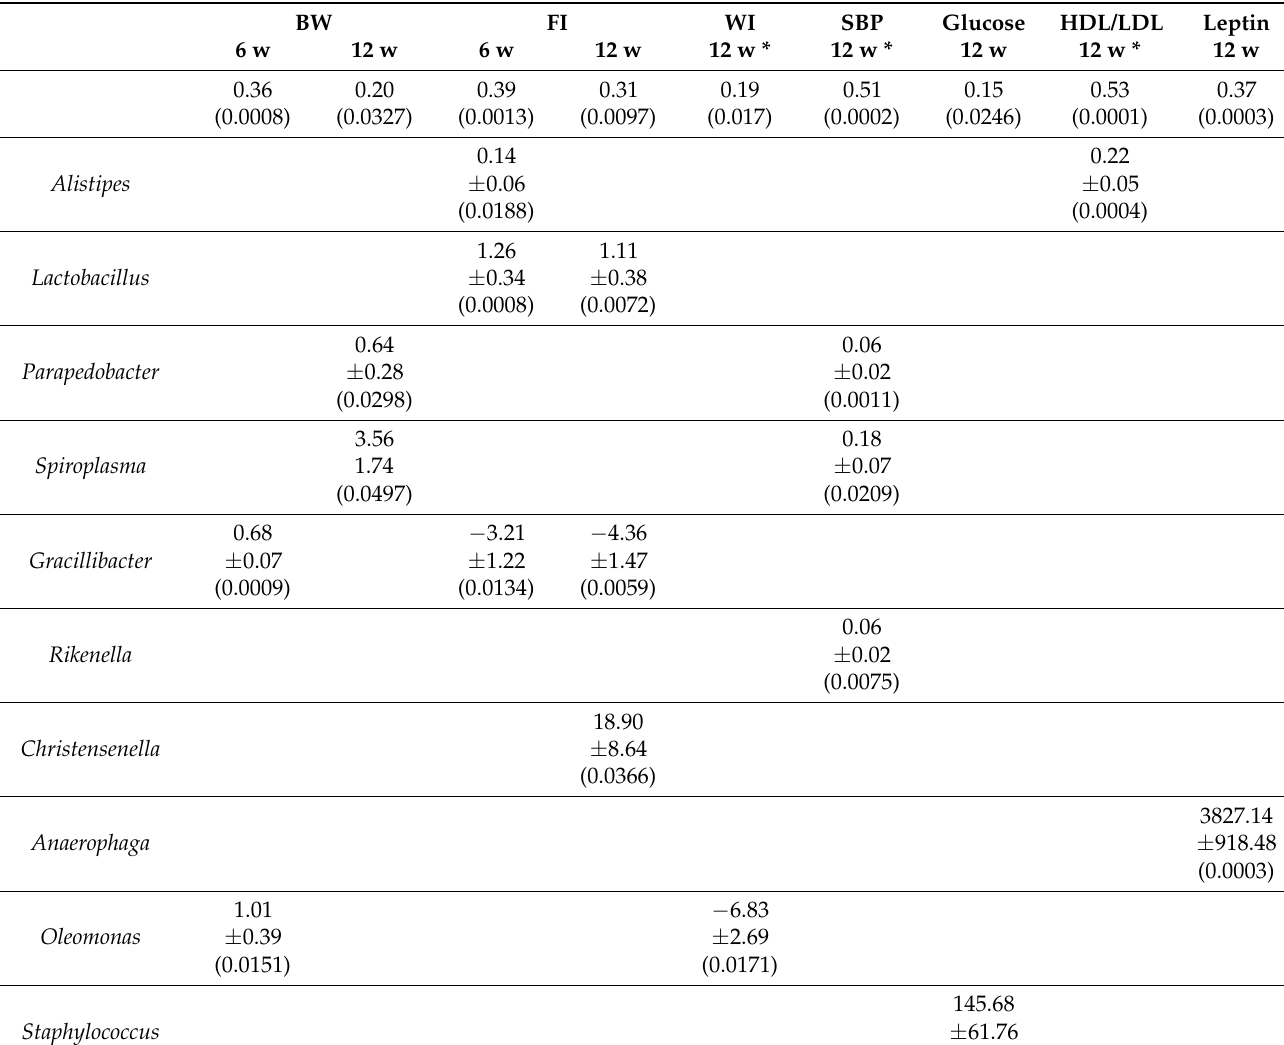
Table 2. Regression fits for each of the physiological variables studied using as independent variables those genera that show statistical differences in the percentage of sequences retrieved from fecal samples. BW, body weight; FI, food intake, WI, water intake; SBP, systolic blood pressure. BW FI WI SBP